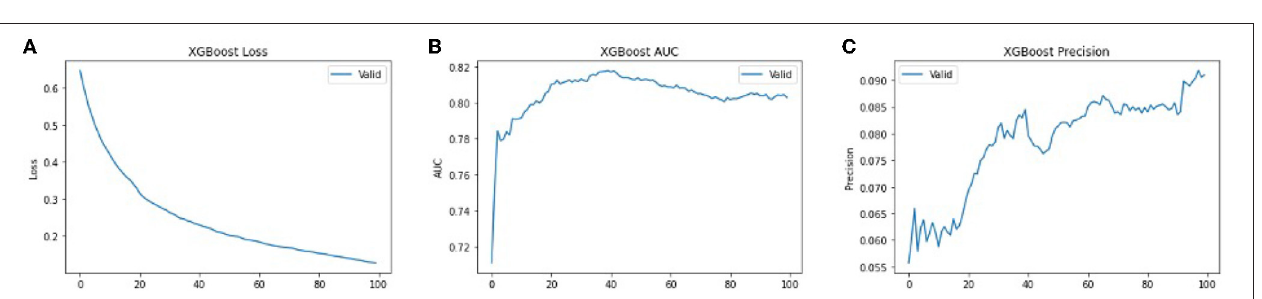
FIGURE 8 | The performance metrics of different architecture of XG-Boost with variable number of epochs (A) Loss, (B) ROC, and (C) Precision.